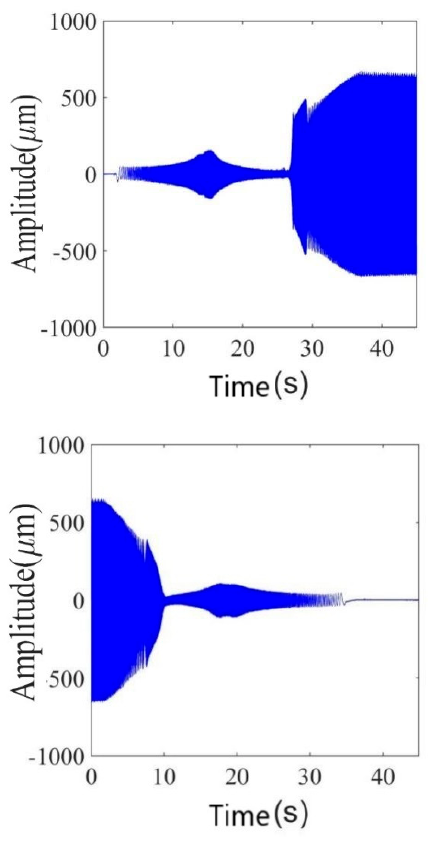
Figure 22. Time-resolved vibration amplitude in the rotating disk during the processes of accelera- tion and deceleration at the oil pressure level 0.2 MPa. and deceleration at the oil pressure level 0.2